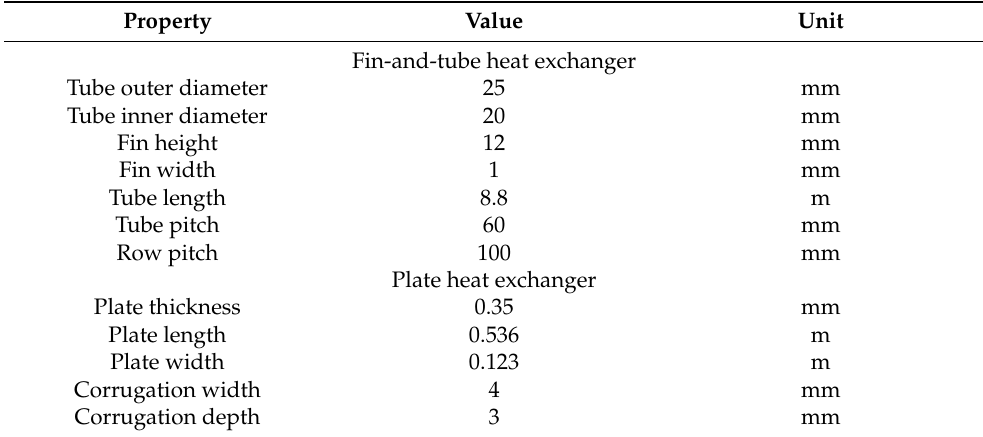
Table 4. Main parameters of